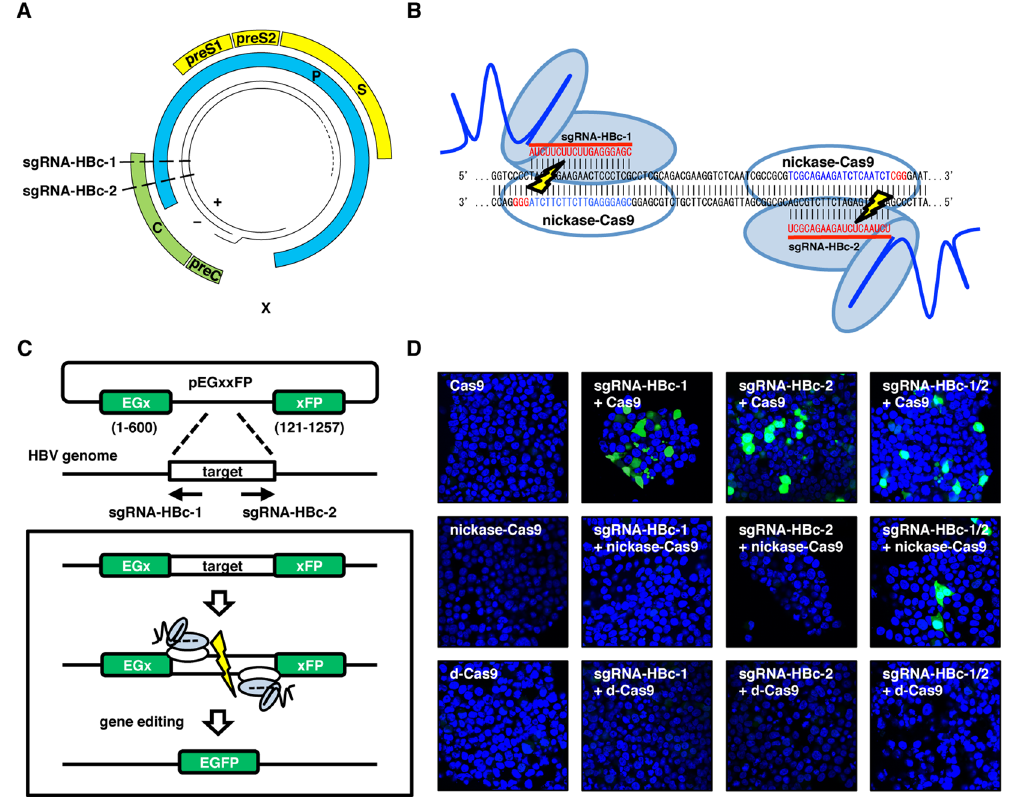
Figure 1. Cas9-based systems for gene editing and HBV-specific sgRNAs targeting sites for Cas9, nickase-Cas9 or d-Cas9. ( A ) Schematic diagram representation of the HBV genome. The four viral transcripts of the core are indicated: C, polymerase; P, surface; S and X, proteins. Regions targeted by sgRNAs are indicated. ( B ) The DNA sequences targeted by nickase-Cas9 with the pair sgRNA-HBc-1 and sgRNA-HBc-2 in the gene coding HBc protein. ( C ) Schematic of the EGxxFP assay performed to analyze the cleavage effects of Cas9, nickase- Cas9 and d-Cas9 expression with sgRNA-HBc-1 and sgRNA-HBc-2. A split EGxxFP plasmid is inserted with the targeted HBV sequence, and a recombination of EGFP is induced by DSBs on the targeted sequence. ( D ) Plasmids encoding Split EGxxFP possessing the HBc sequence, Cas9, nickase-Cas9, d-Cas9, and the sgRNAs were transfected into 293T cells. EGFP fluorescence was detected at 24 hr